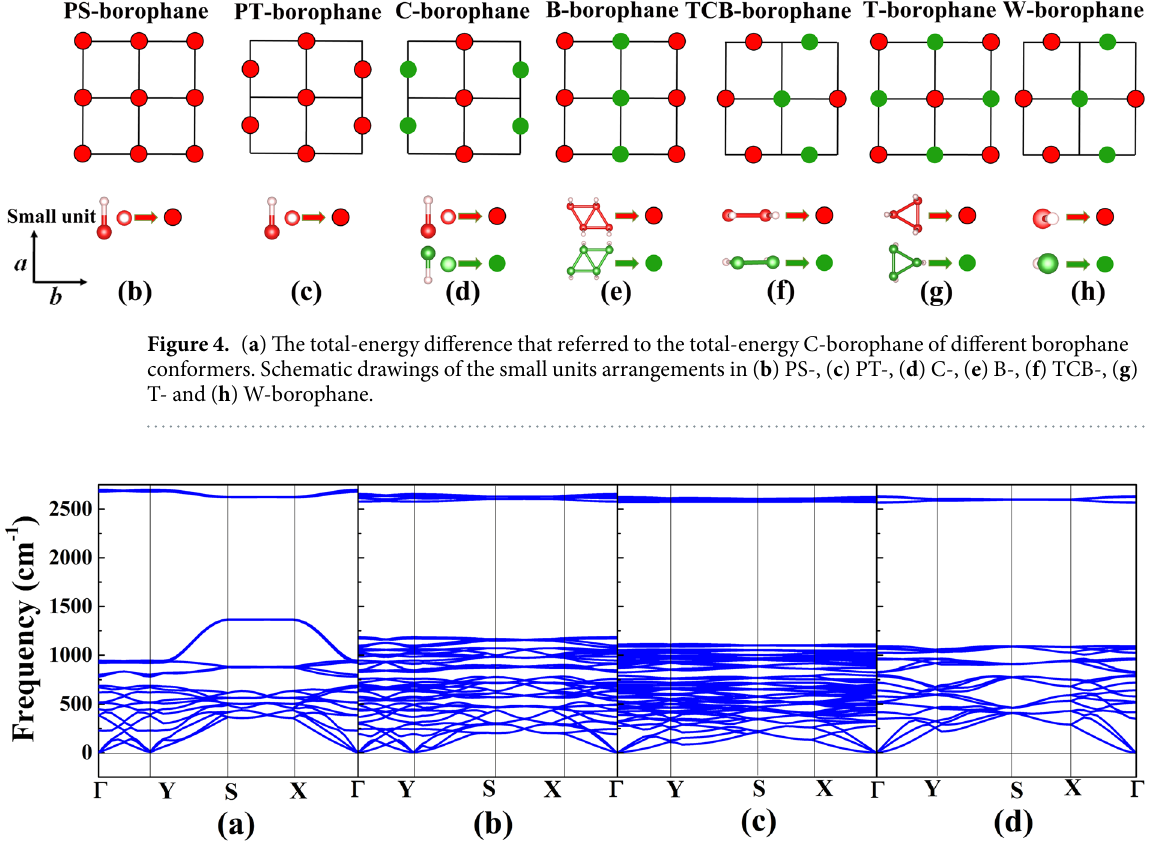
Figure 5. The phonon dispersions of ( a ) B-, ( b ) TCB-, ( c ) T- and ( d )